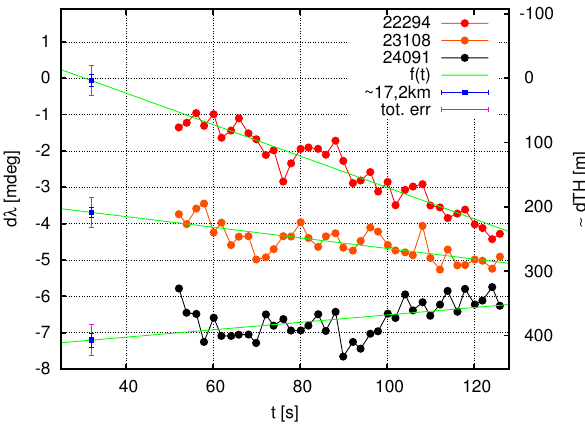
Fig. 6. Fitted EAOs dλ versus measurement time t for the oc- cultation states of the orbits 22294 (5 June 2006), 23108 (1 Au- gust 2006), and 24091 (9 October 2006). Added are the linear fits ( f (t) ) through these values. The blue square marks the extrapolated EAO at 17.2km with the fit error. The violet error bar indicate the total error of the EAO at this altitude (see Sect.